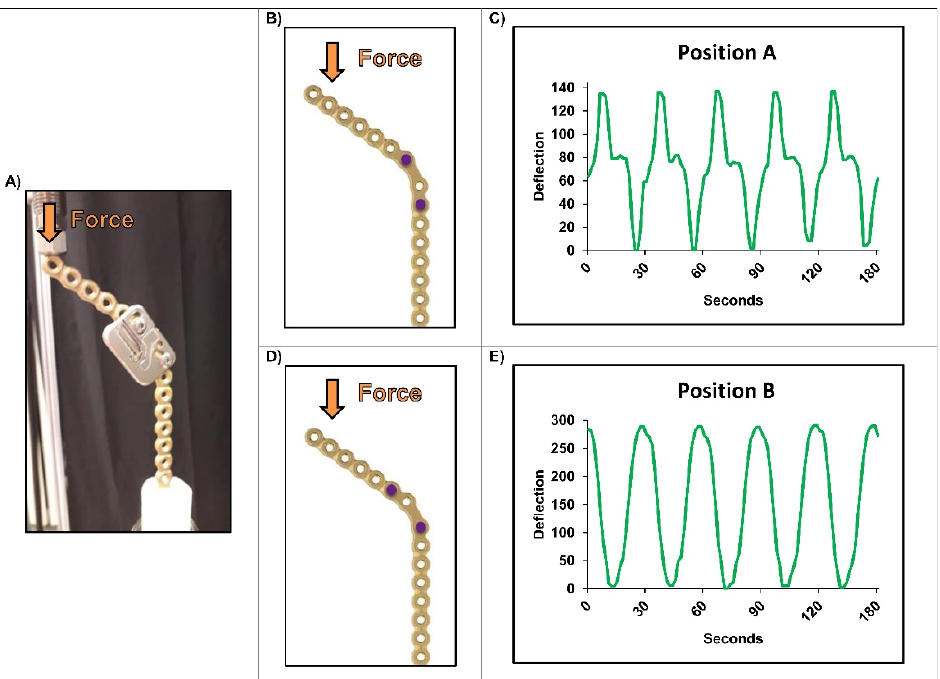
Figure 3. First compression experiment of the strain measurement device mounted to a 2.8 mm Ma- trix Mandible plate ( A ): ( B , C ) Insufficient detection of a sinusoidal movement (displacement